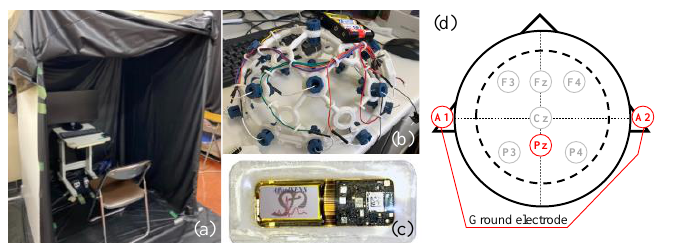
Figure 1. Experimental processes ( a ) for each of the trials and ( b ) for the entire experiment.